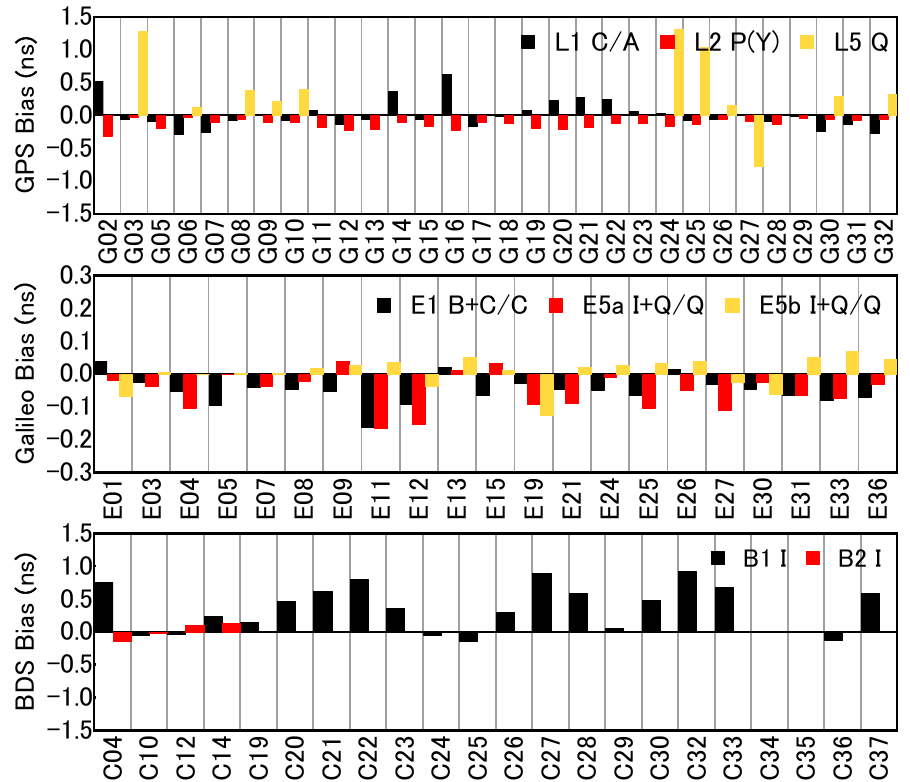
Figure 3. Receiver-related pseudorange biases of baseline KOKB_KOKV for GPS ( top ), Galileo ( middle ) and BDS ( bottom ). This baseline equipped with SEPTENTRIO and JAVAD